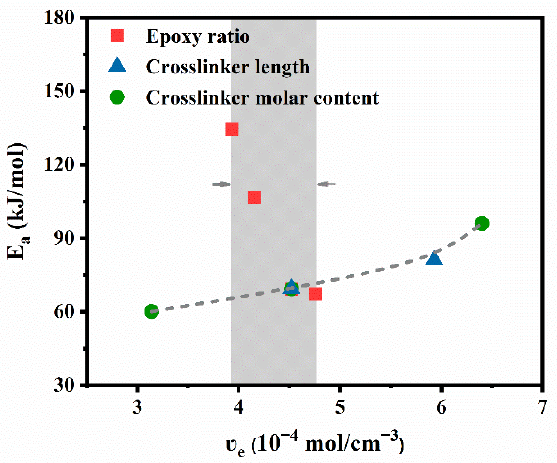
Figure 5. The relationship between activation energy and the crosslinking density.